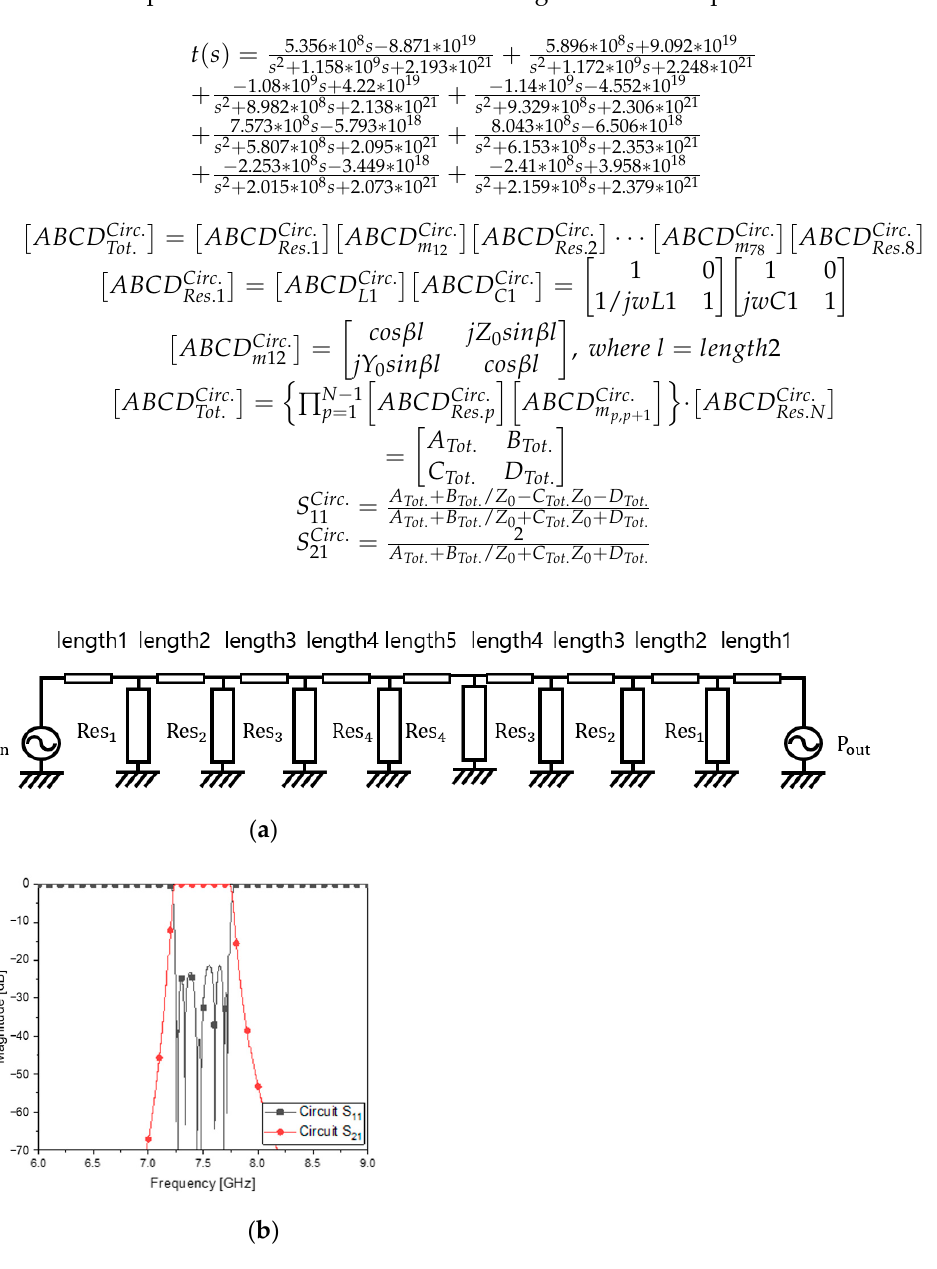
Figure 2. Modified equivalent circuit and its frequency response: ( a ) circuit ( b ) S 11 and S 21. Table 2. Calculated unknowns of Figures 1 and 2 for the required BPF.